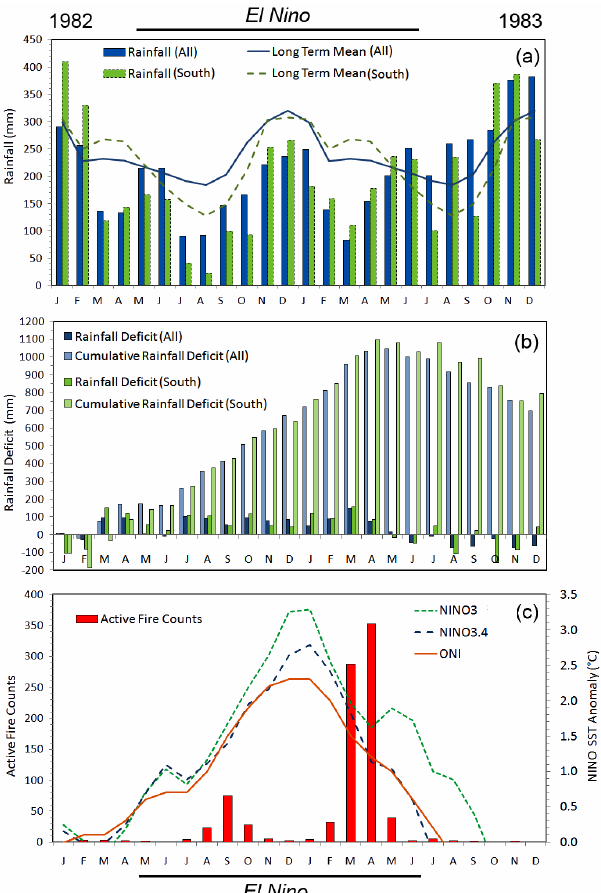
Fig. 7. Rainfall, ENSO index and active fire count data for the strong 1982–1983 El Ni˜no. (a) Mean monthly rainfall for Borneo derived from the NOAA Climate Prediction Centre Merged Analy- sis of Precipitation dataset (Xie and Arkin, 1996, 1997), calculated for the whole of Borneo and for the south of Borneo, along with the respective long term monthly means, (b) rainfall deficit and cumu- lative rainfall deficit, calculated from the CMAP rainfall data shown in (a) , and (c) monthly active fire counts derived from 105 AVHRR GAC images, together with the matching set of NINO3, NINO3.4 and ONI SST anomaly measures taken from the NOAA Climate Prediction Centre (NOAA, 2011a). Peaks in fire activity seen in August–October 1982 and February-May 1983 broadly match the periods of greatest rainfall deficit. Months are classed as being ex- periencing El Ni˜no conditions only if they have an ONI greater than or equal to 0.5 ◦ C for a consecutive period of at least 5 months (Kousy and Higgins, 2007). The El Ni˜no episode defined by this criterion is indicated by the black bar above and below the